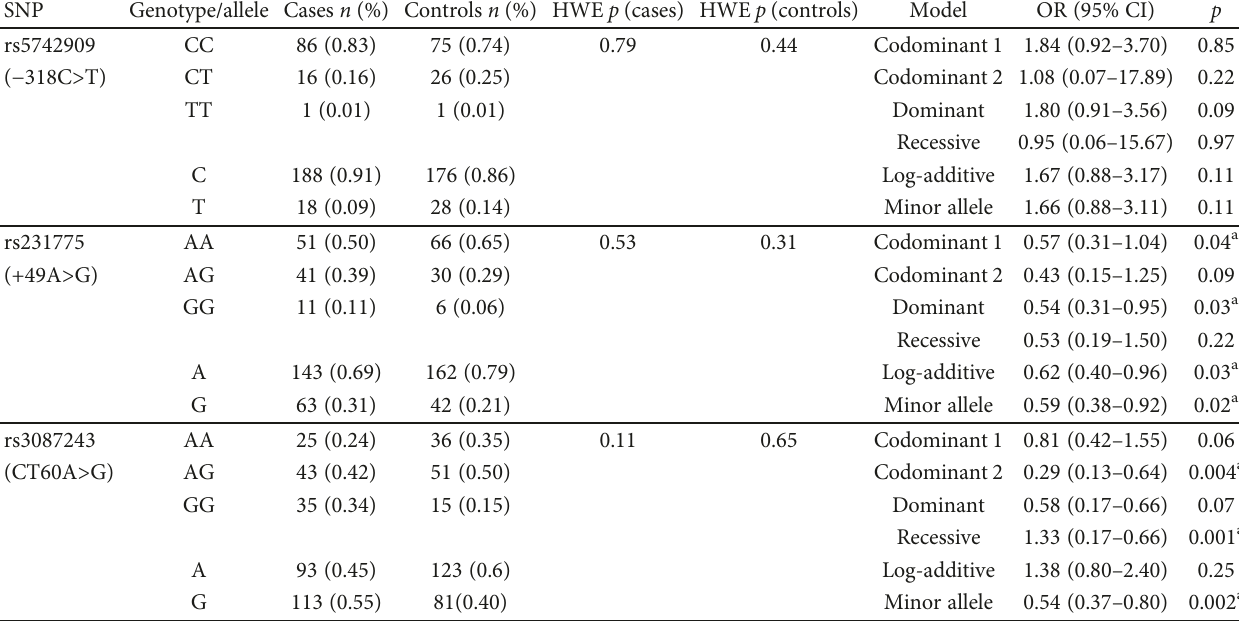
Table 3: Genotype and allele frequencies of CTLA-4 gene polymorphisms in Pv patients and control and the association of these polymorphisms with